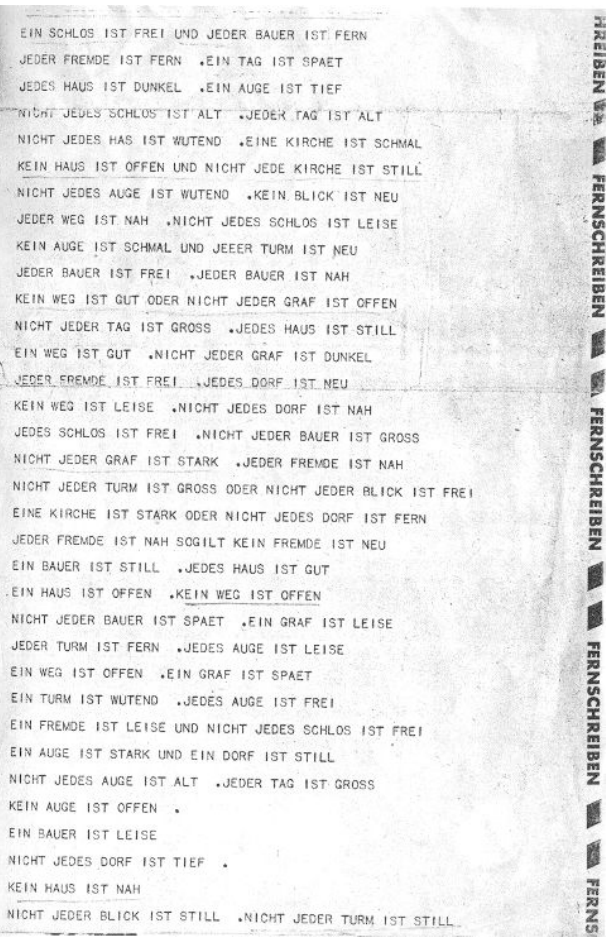
Figure 5. Theo Lutz, Stochastic text.